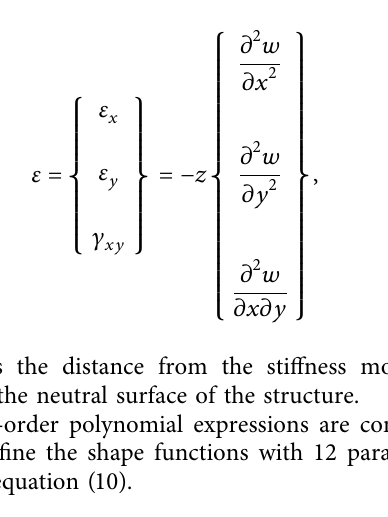
Figure 2: Measurement points and stifener on the plate-like structure under natural